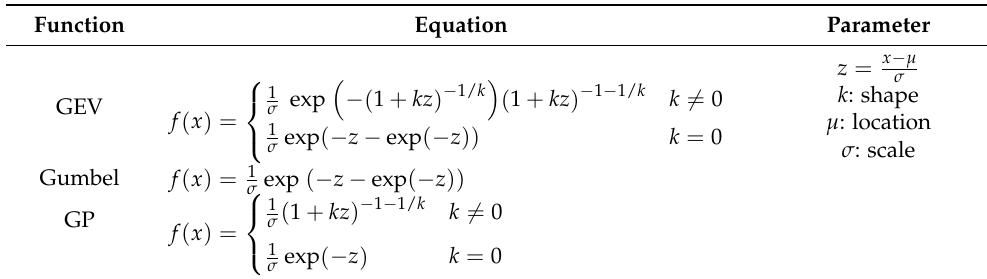
Figure 3. Flowchart showing the development of IDF curves. Table 3. Probability distribution functions used to fit observed dataset and satellite rainfall data at different